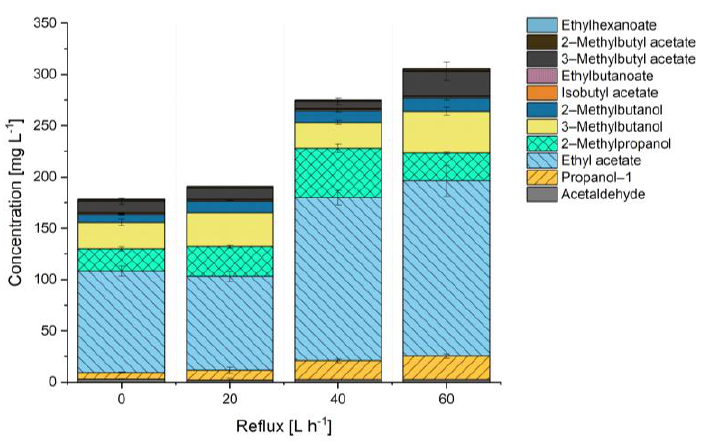
Figure 3. Individual and overall concentrations of the fermentation by-products present in the aromawater as a function of the value of the reflux rate (0−60 L h −1 ).